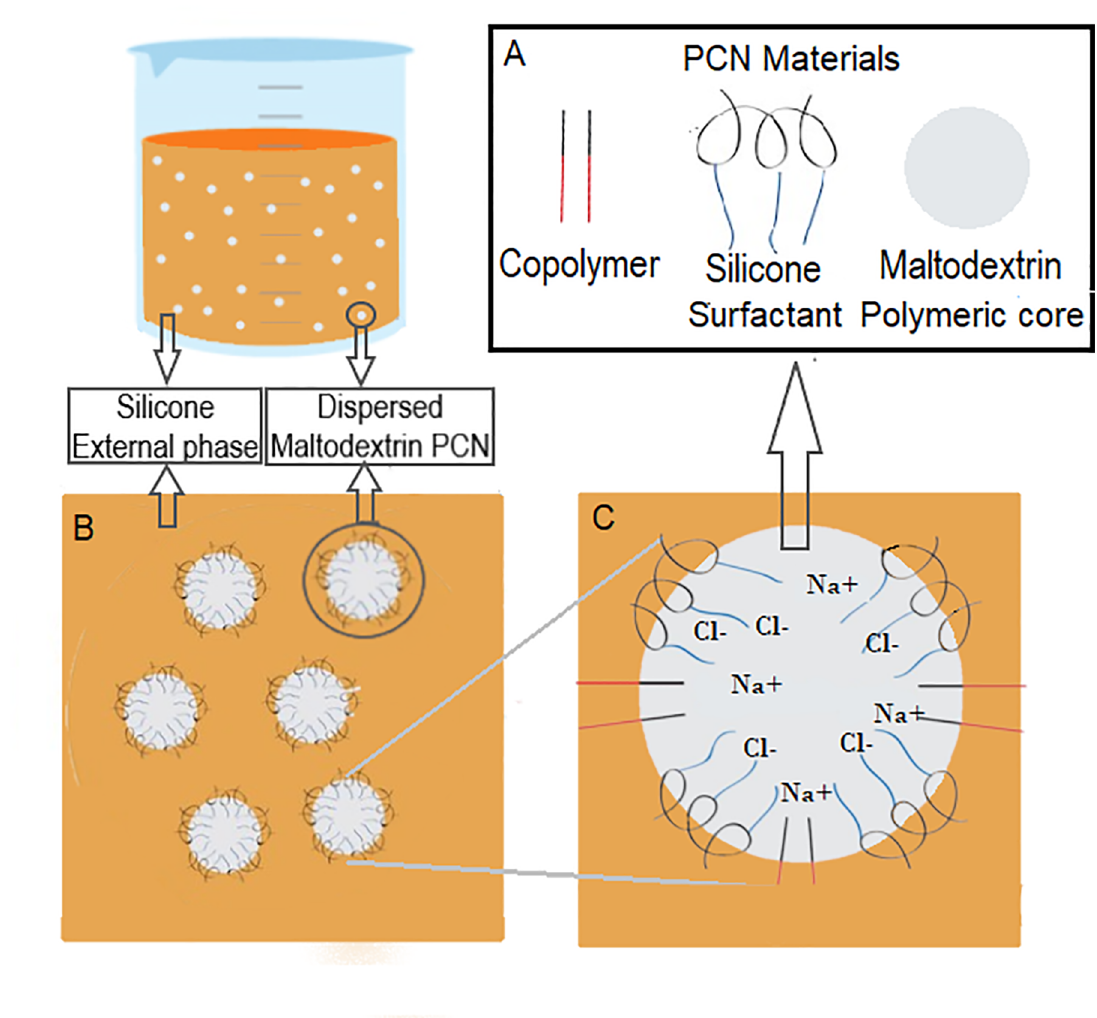
Figure 5. Schematic representation of maltodextrin PCN dispersion in silicone ( A ) maltodextrin PCN materials composition. ( B )Amplification of maltodextrin PCN dispersion in silicone. ( C ) Representation of maltodextrin PCN materials disposition in silicone dispersion.